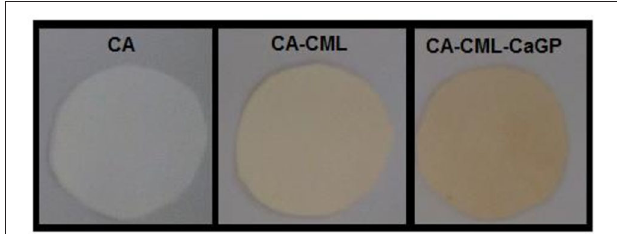
FIGURE 1 | Photo of membranes produced.